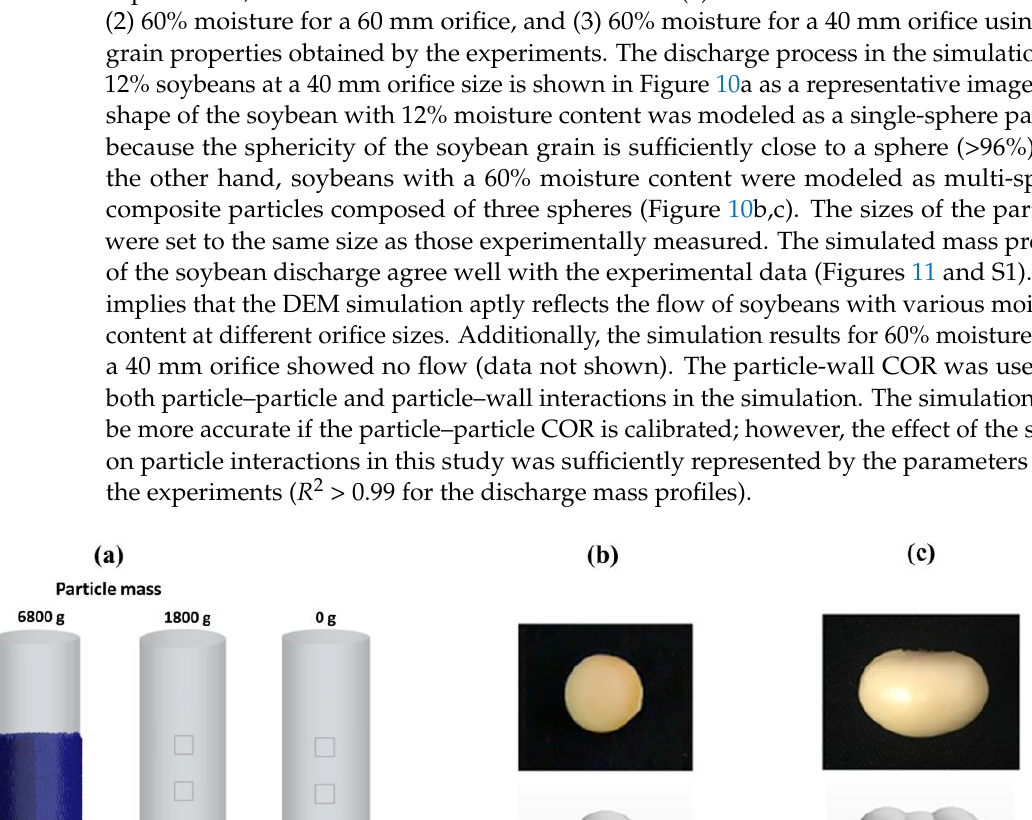
Figure 11. Mass profiles for soybeans with 12% and 60% moisture content at 40 and 60 mm orifice sizes, respectively, obtained by experiments and simulations during discharge.